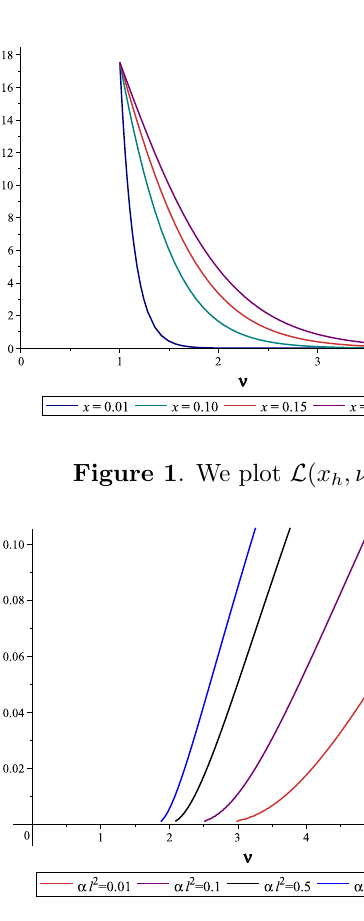
Figure 2 . We plot x h ( (cid:23) ) for di(cid:11)erent (cid:12)xed values of (cid:11)l 2 : (cid:11)l 2 < 1 (left) and (cid:11)l 2 > 10 (right). We restrict ourselves to the range x h 2 [0 ;